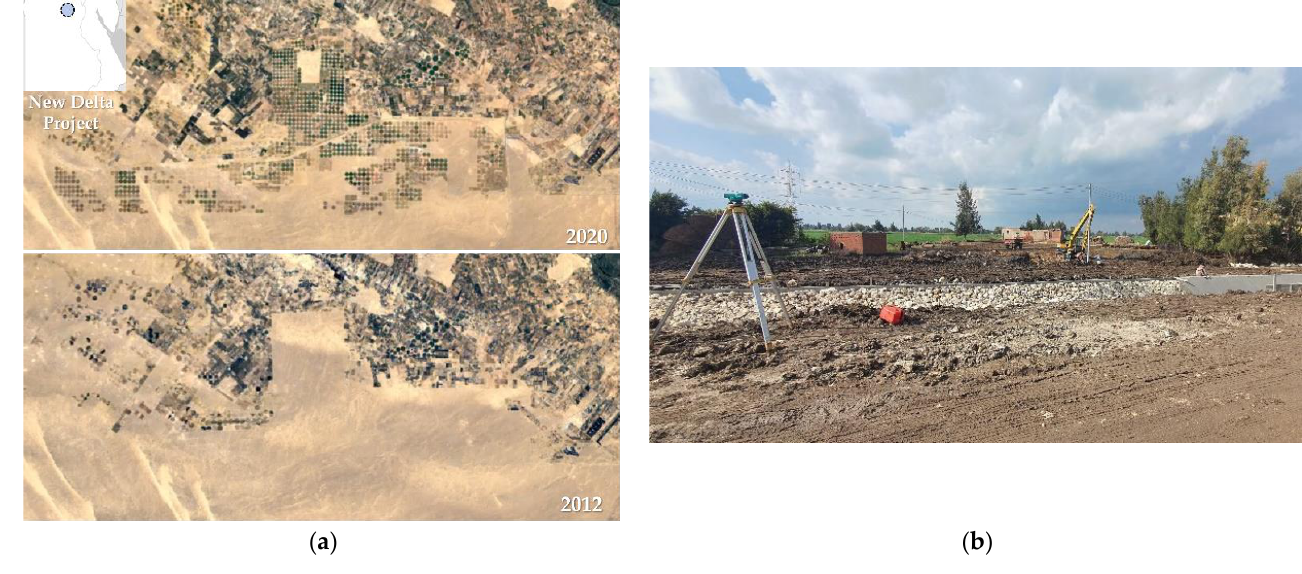
Figure 6. ( a ) An example of increasing the reclaimed land areas: New Delta national Project be- tween 2012 and 2020 (Google Earth Engine, 2022) Available online: https://earthen- gine.google.com/time-